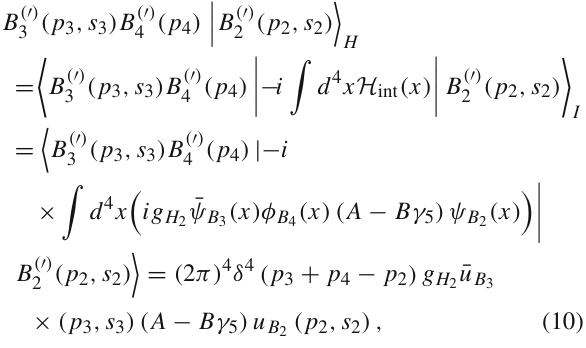
(Fig. 2). The B as hadronic form factors, while the B tion, with one final-state B be reduced